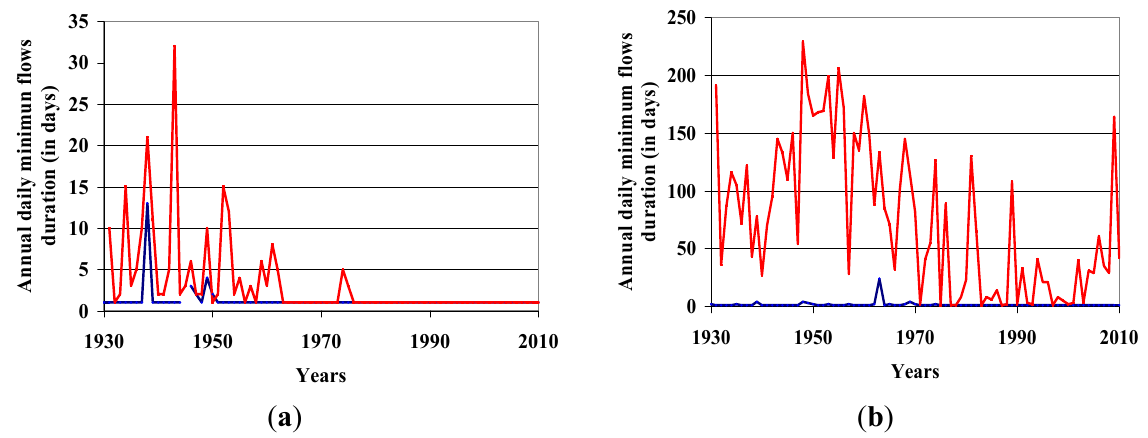
Figure 5. Comparison of the temporal variability of AMEF duration from the Matawin dam (red curve) from 1930 to 2010 ( a ) the L’Assomption River (blue curve) and Matawin River upstream; ( b ) the Ouareau River downstream from the Rawdon dam (blue curve) and in the Matawin River downstream.